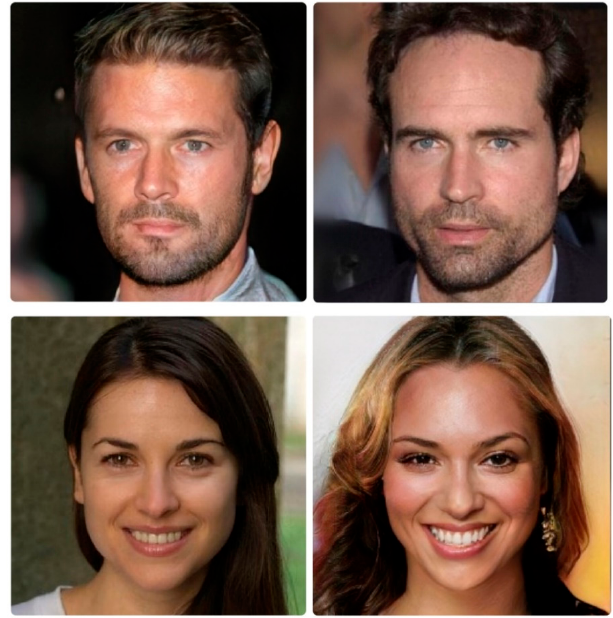
Figure 1. Example of computer-generated images generated by GAN (One of these is a photo of a real face, other faces are completely created by a